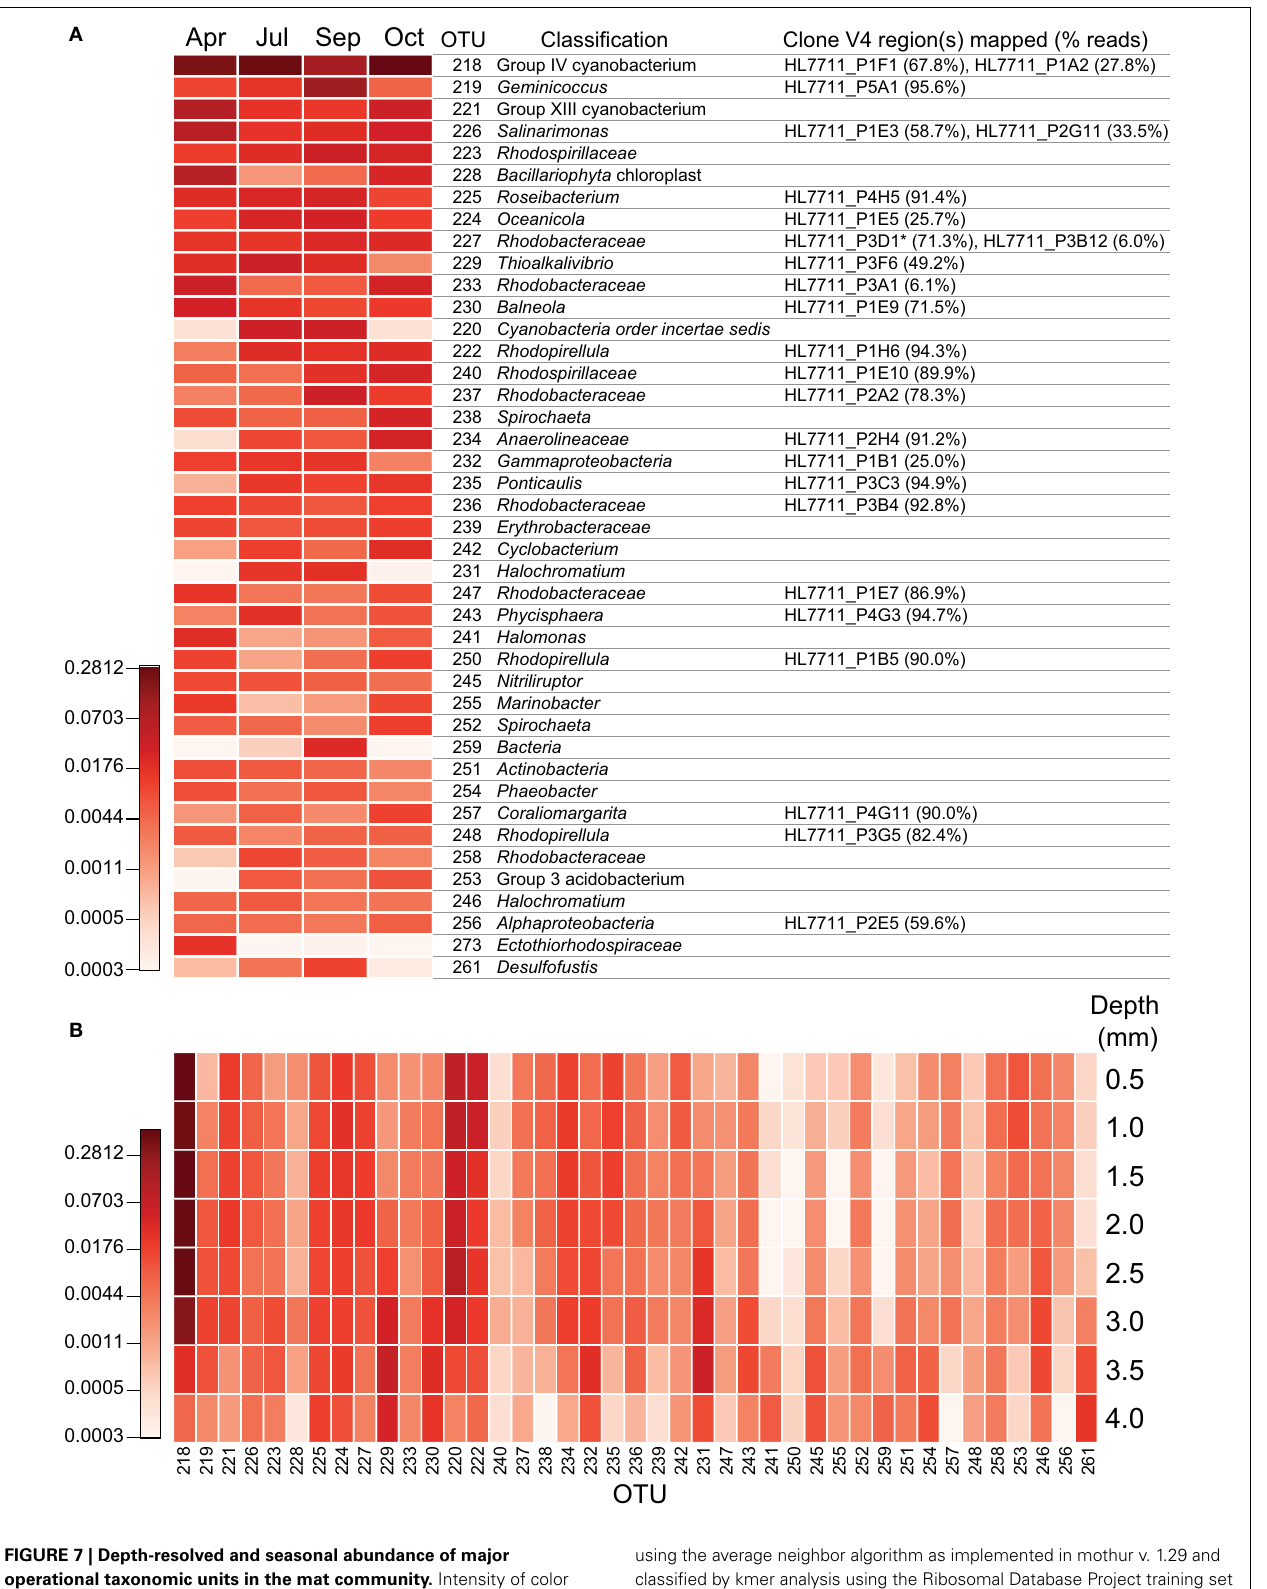
FIGURE 7 | Depth-resolved and seasonal abundance of major operational taxonomic units in the mat community. Intensity of color depicts log 2 transformed relative abundance data. (A) Seasonal cycling of major mat OTUs. After processing, reads were clustered at 97% identity